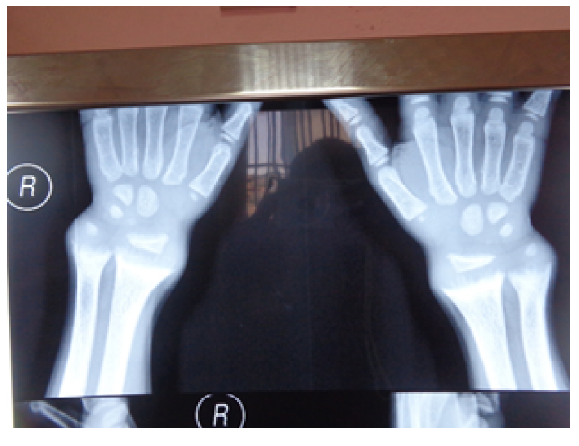
Figure 3. Cupping and fraying epiphyseal